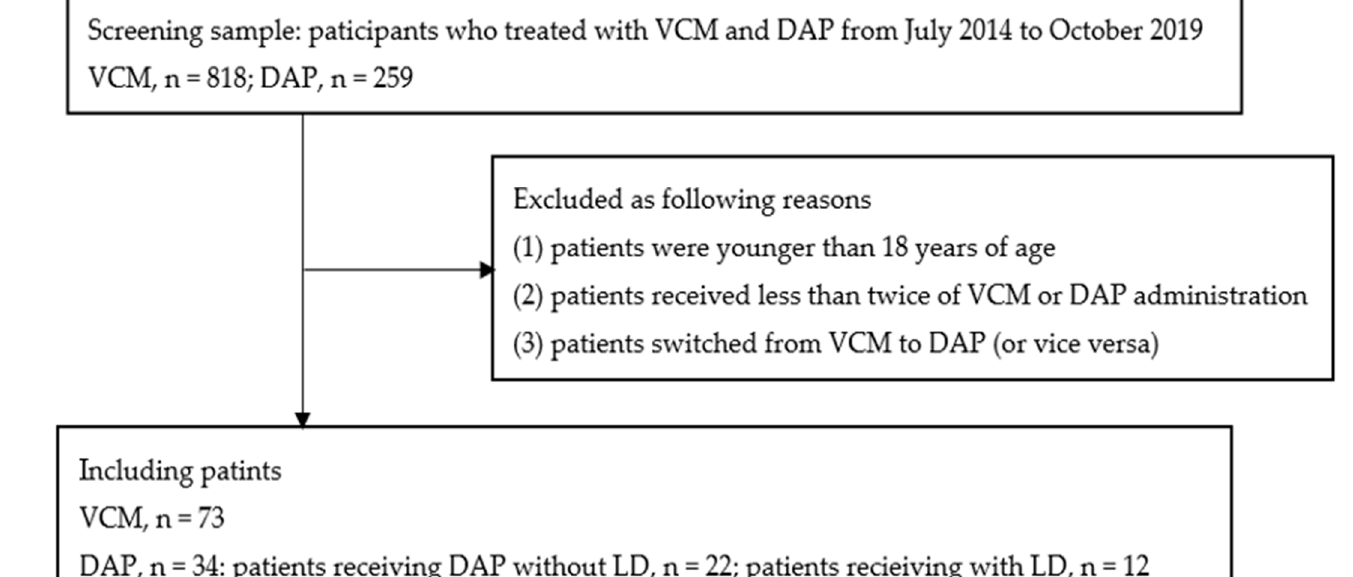
Figure 1. Flow diagram of study participants. DAP, daptomycin; LD, loading dose; VCM, vancomycin.